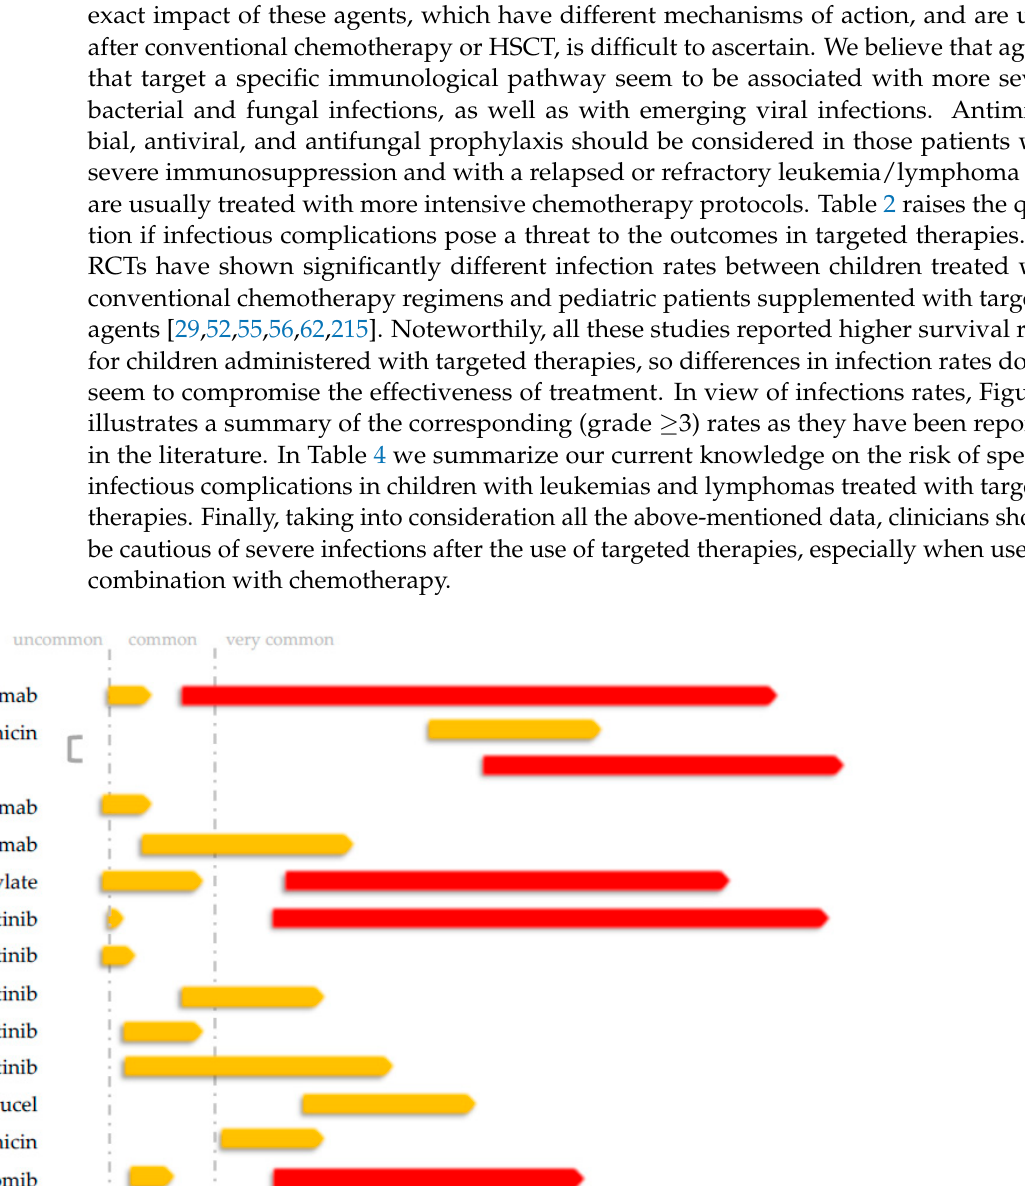
Table 4. Risk of specific infectious complications and suggested prevention strategies.